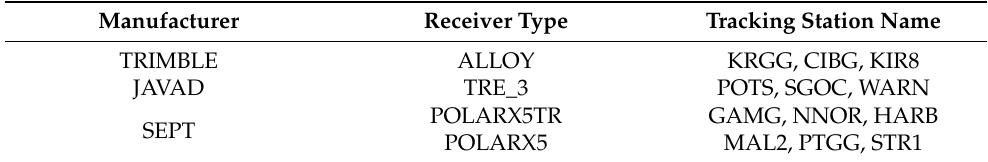
Table 1. The details of the GNSS receivers of the selected